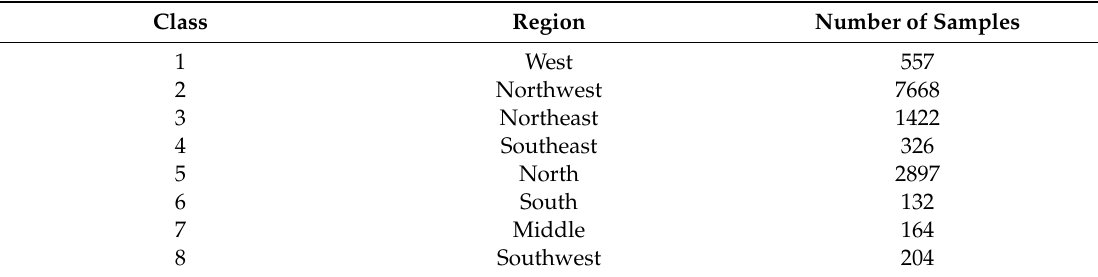
Figure 3. Raw near-infrared (NIR) spectra of 8 samples from 8 different regions. Table 1. Regional distribution of all samples